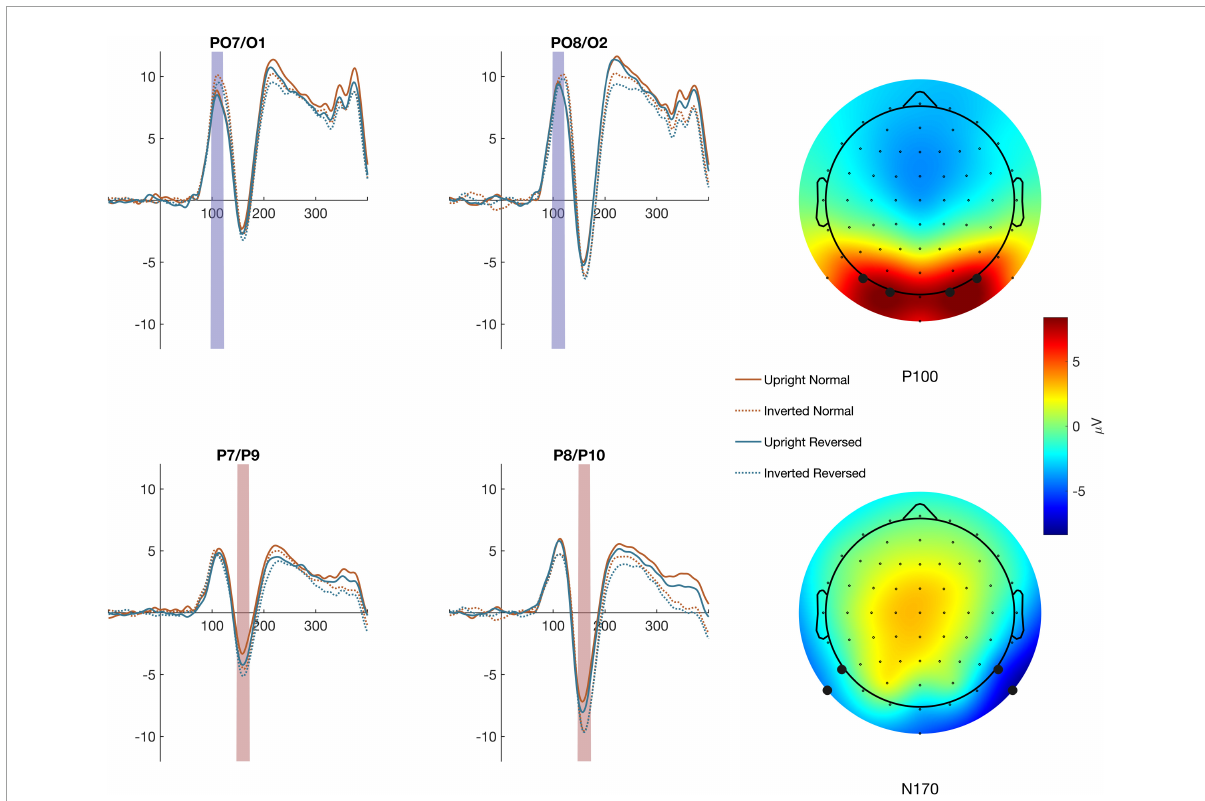
FIGURE2 Averages across the channel montages used to define the P100 (top traces) and N170 (bottom traces) are shown for each condition The colored regions highlight the timepoints used to calculate ERP amplitude. The mean activity across the time windows is shown in the topographic maps to the